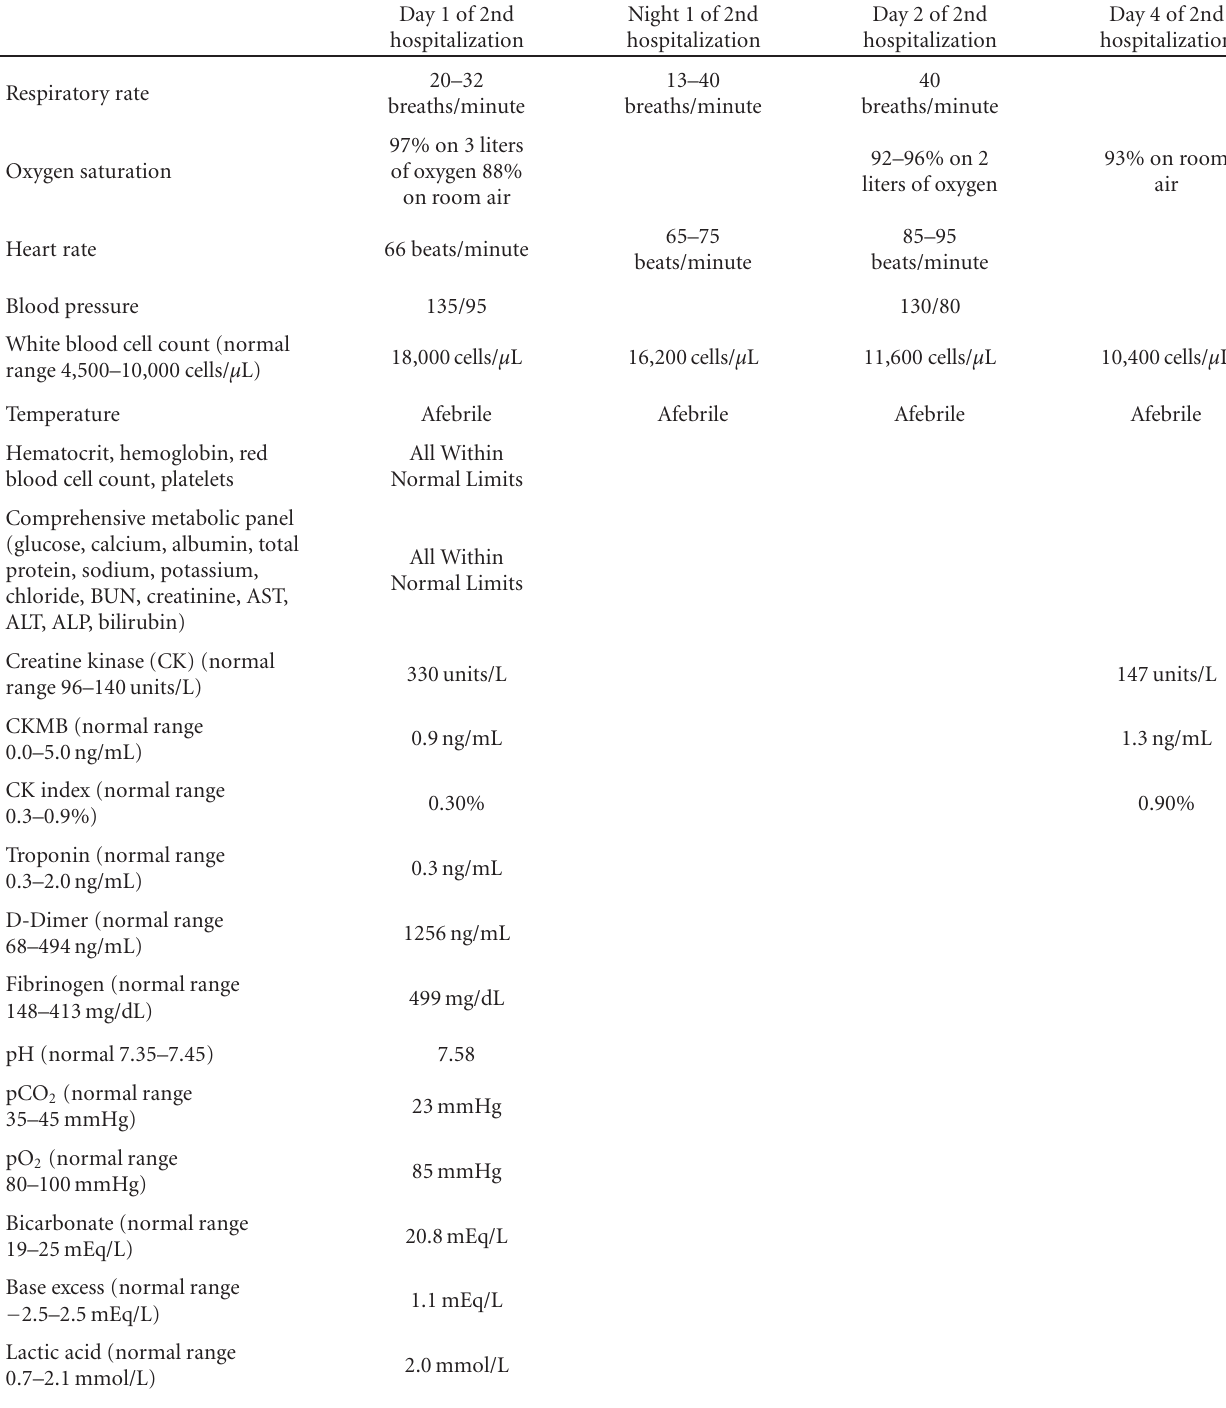
Table 1: Second hospitalization (6 days after shoulder